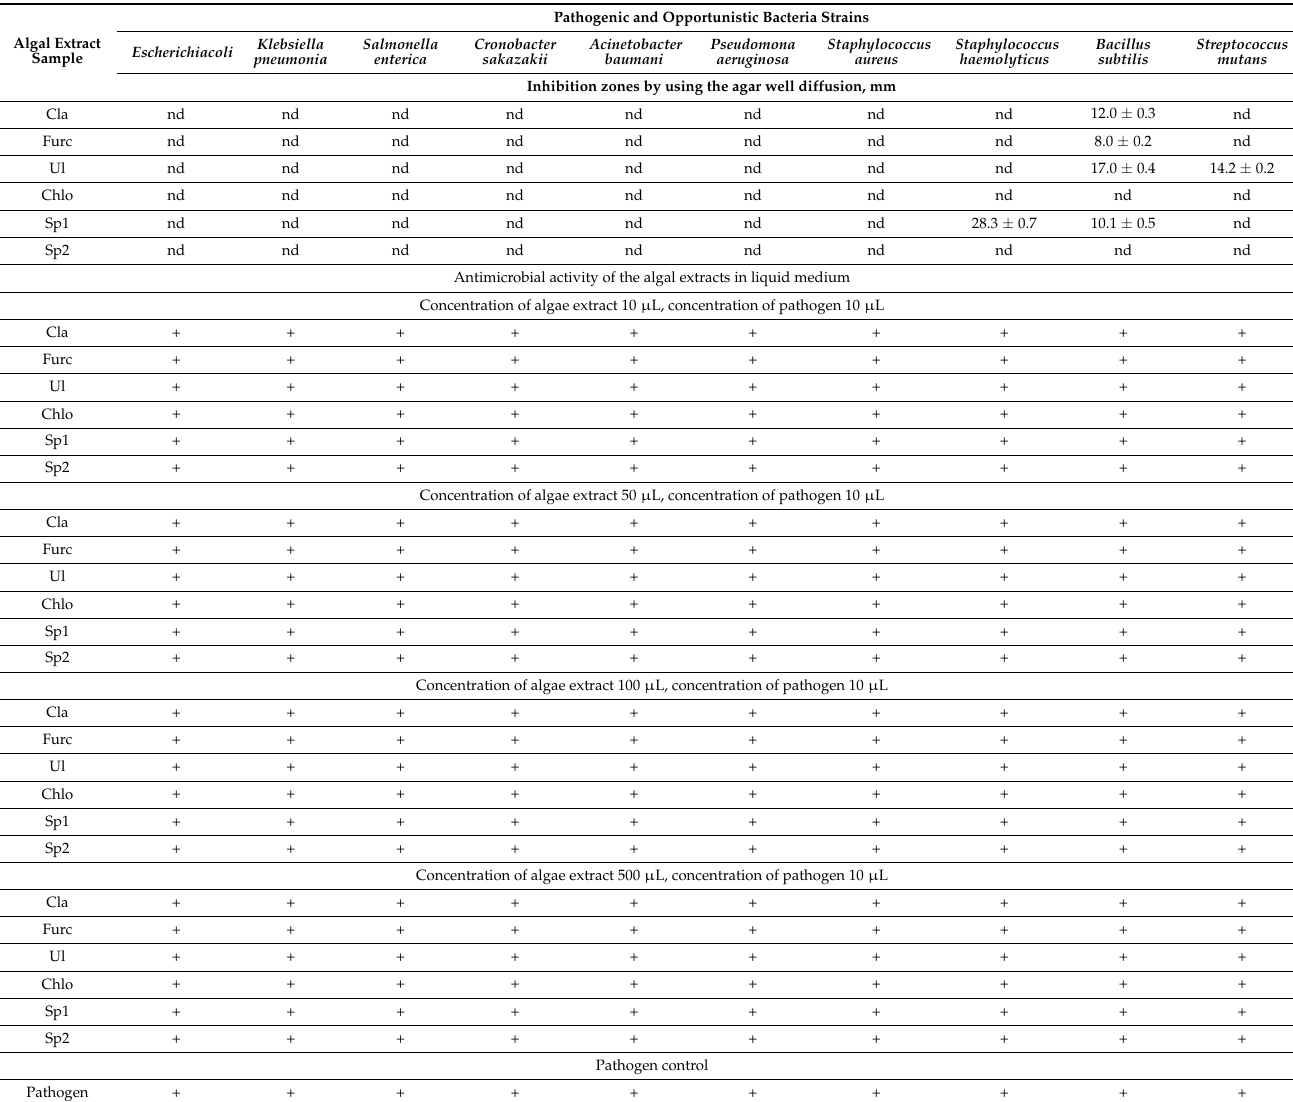
Table 2. Antimicrobial activity of the algal extract samples assessed by using the agar well diffusion and liquid medium methods. AlgalExtract